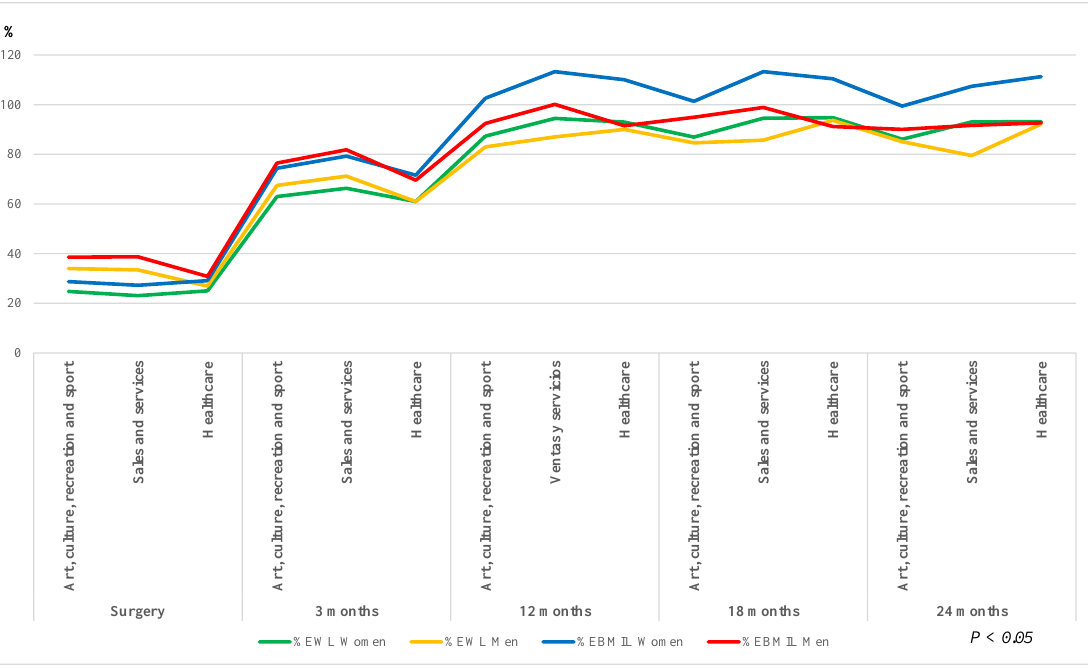
Figure 3. Evolution of related weight variations by professional occupation and gender. Measurement units: % excess weight loss (EWL) and % excess of body mass index loss (EBMIL).